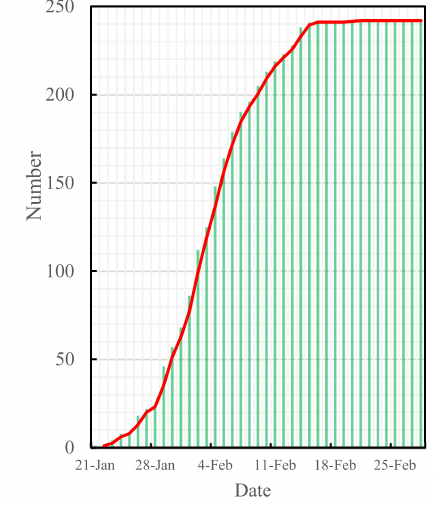
Figure 2. Cumulative confirmed cases in